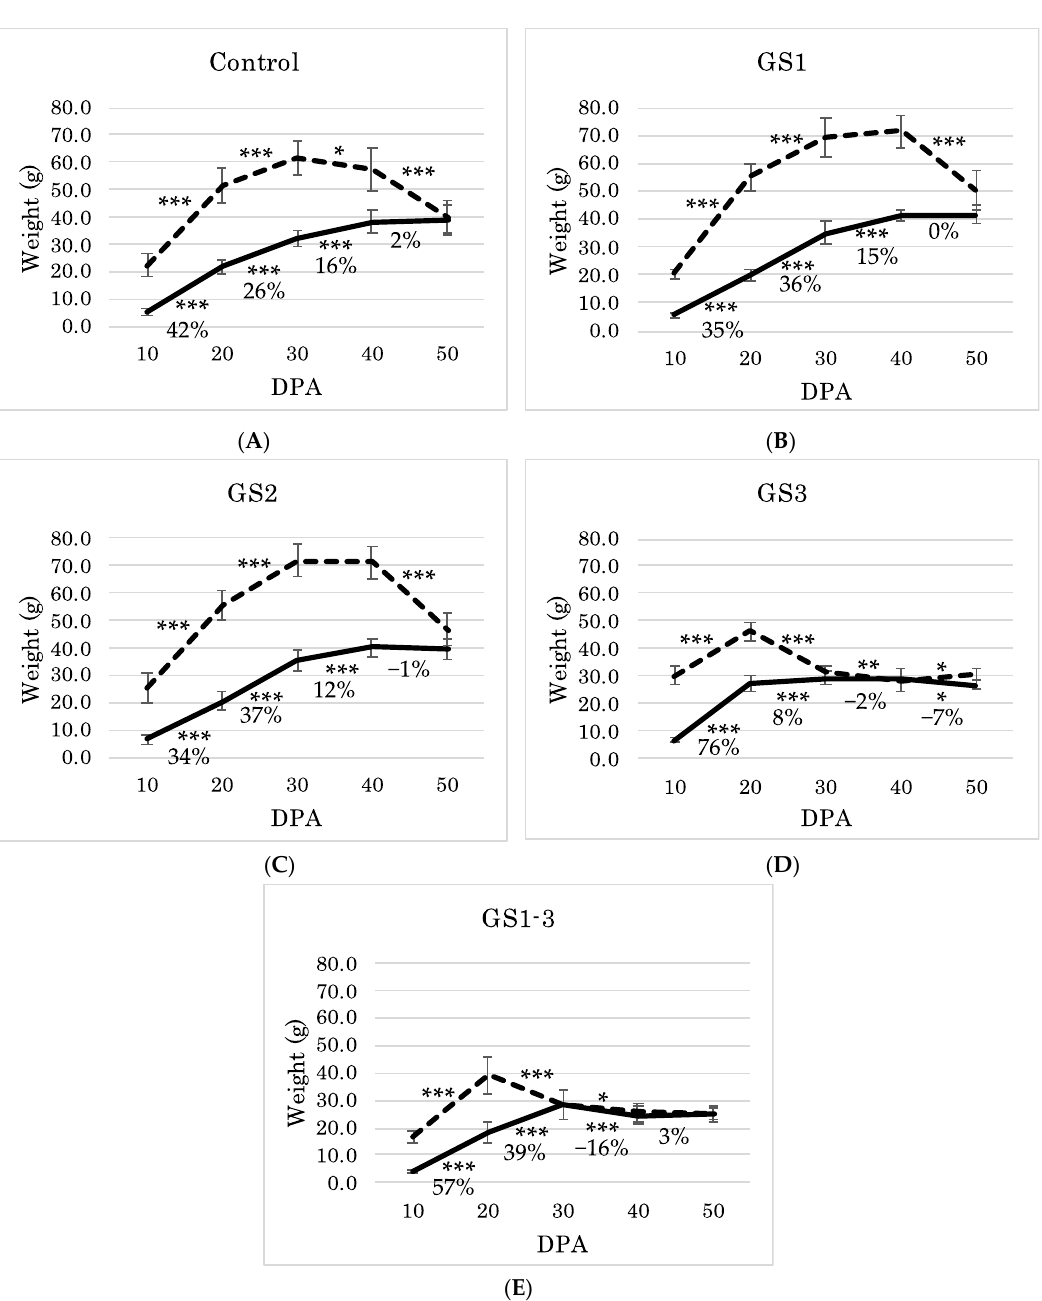
FT in those plants (Figure 4). As in the control, FW of seeds on plants exposed to heat